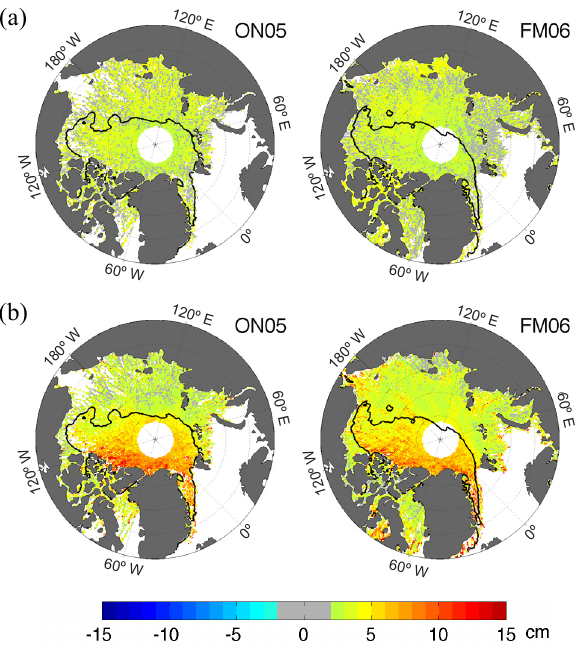
Figure 9. Adjustments of freeboard retrieved using the TP method accounting for (a) snow depth on top of new ice in leads and (b) lead width with respect to ICESat footprint area for the periods ON05 and FM06. These adjustments are estimated following the methods described in Kwok and Cunningham (2008) and Kwok et al.